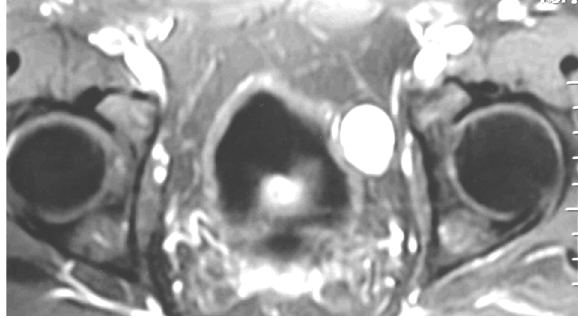
Figure 1 – Magnetic resonance imaging scan showing exophytic tumor in left lateral bladder wall, hyperintense on